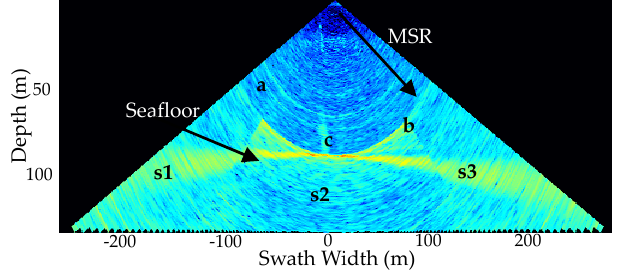
Figure 1. A multibeam water column (MWC) image was generated by self-developed software: a and b depict the side-lobe effect and the Minimum Slant Range (MSR), respectively; c denotes a gas plume; and s1–3 are the three sectors of the ping fan image, respectively.